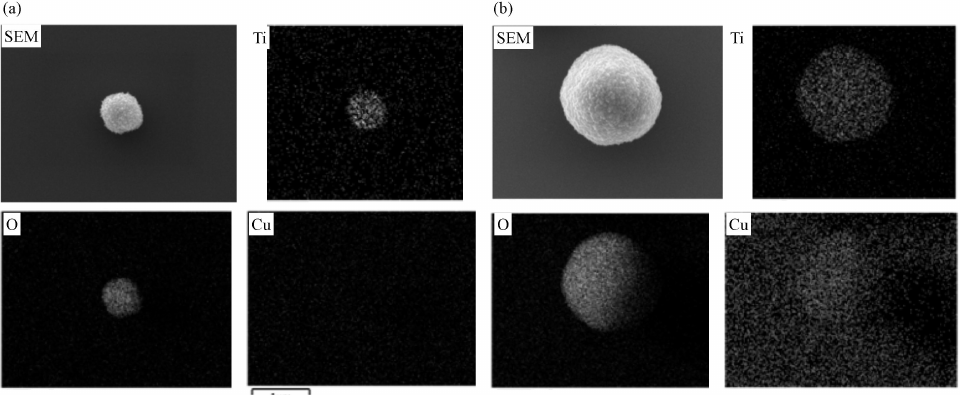
Figure 9. SEM and EDS mapping of ( a ) undoped and ( b ) Cu doped TiO 2 . Cu nitrate concentration was 10